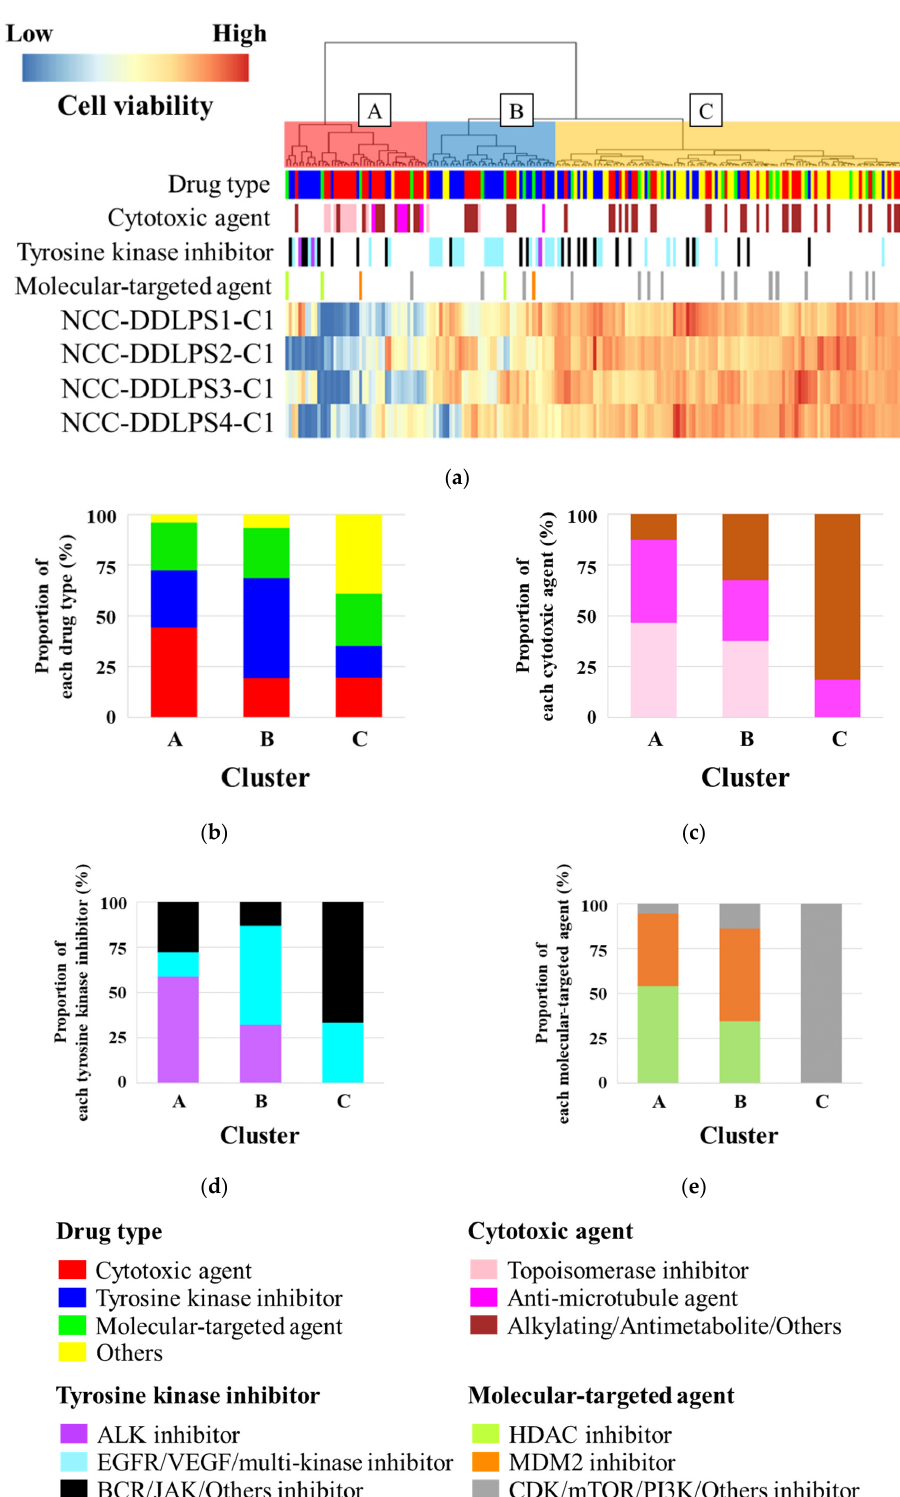
Figure 5. Drug screening using 197 drugs. ( a ) Unsupervised hierarchical clustering showing the antiproliferative effect of each drug on NCC-DDLPS4-C1 cells. Drugs are categorized into three clusters (cluster A: effective group; cluster B: intermediate effect group; cluster C: poor effect group). ( b – e ) The proportion of each drug type categorized into clusters A, B, and C. The graphs are depicted after normalization of the number of